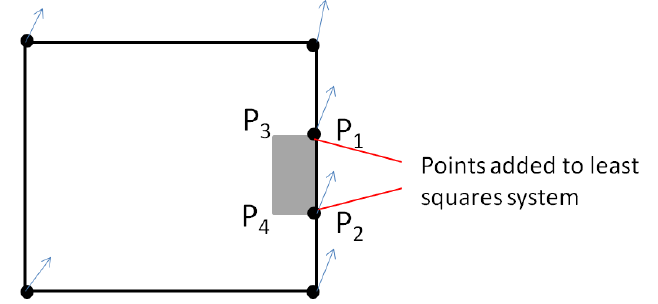
Figure 13. Propagation for topologically connected objects: the connected points are